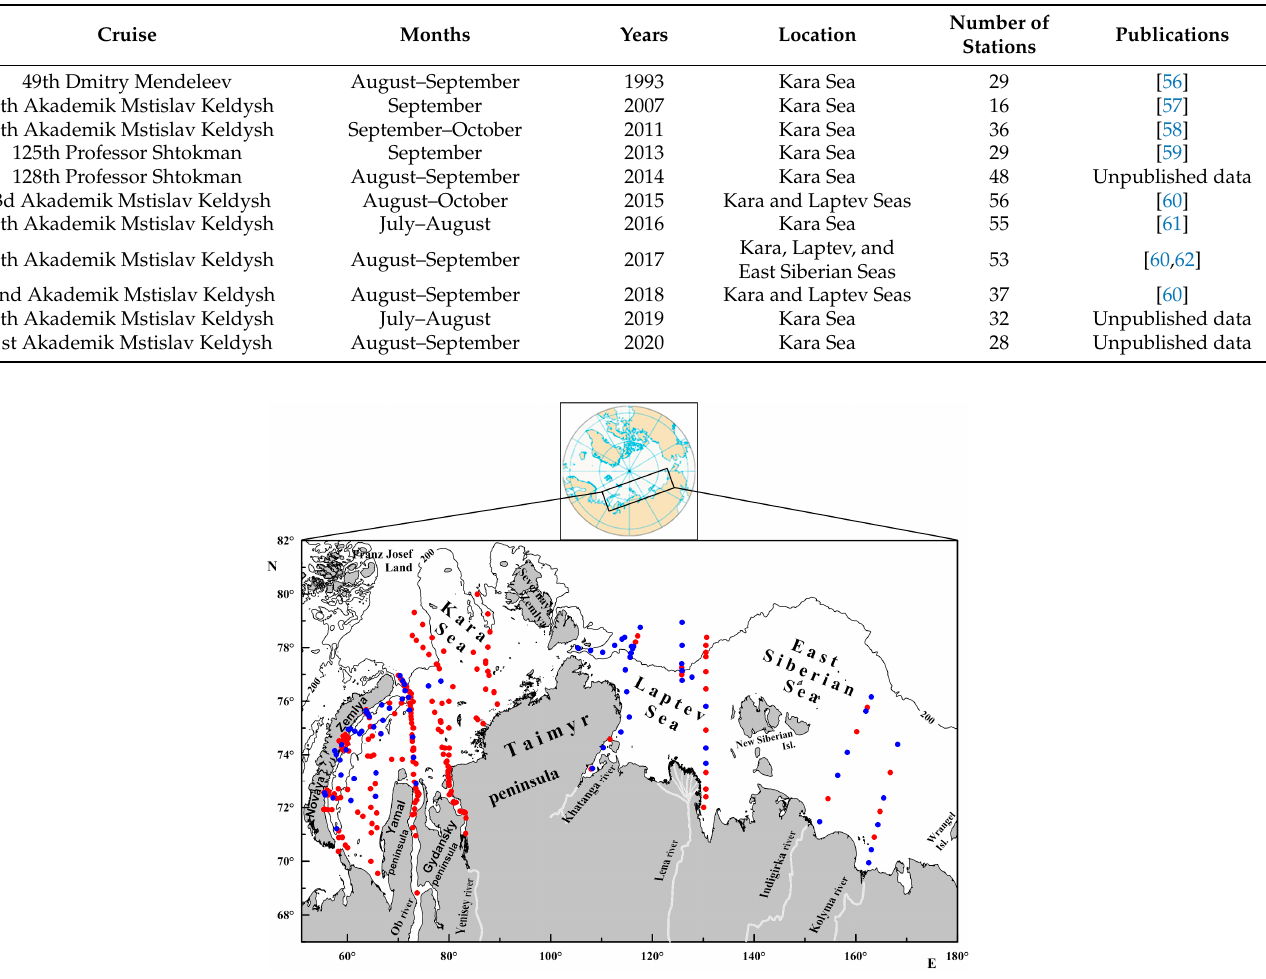
Figure 1. Locations of the sampling sites in the Siberian Seas where the calculations of the optimal assimilation number (P bopt ) were performed. The red circles indicate the sites where the calculations of P bopt of the total phytoplankton were carried out. The blue circles indicate the sites where the calculations of P bopt of size-fractionated phytoplankton were performed. The sampling depths were defined after a preliminary sounding of temperature, con- ductivity, and chlorophyll fluorescence using a CTD probe SBE-19 and SBE-32 (Seabird Electronics Inc., Bellevue, USA). Niskin bottles were deployed at the stations to obtain water samples from discrete depths within the upper 100 m layer. Trace metal cleaning procedures (e.g., Teflon-coated covers and springs for the Niskin bottles) [63] were used during all the cruises. 2.2. The Field Data The methods for determining PP and Chl a are described in detail in previous studies [47,57]. PP was estimated on board using a radiocarbon technique [64] according to sim- ulated in situ approach. Acid-cleaned 160 mL bottles with water samples after the addi- tion of sodium bicarbonate (NaH 14 CO 3 , 0.05 μ Ci per 1 mL of sample) were placed under neutral lighting filters and exposed for half of a light day in a deck incubator with the seawater temperature maintained at the in situ conditions. The transparency of neutral lighting filters was chosen based on the light exposure conditions at the sampling depths after the sounding of underwater photosynthetically available radiation (PAR). After ex- posure, the samples were filtered onto a 0.45 μ m nitrocellulose membrane “Vladipore” (Vladipore, Vladimir, Russia). After filtration, the samples were treated with 0.1 N HCl and filtered seawater, dried overnight, and placed in a scintillation vial with 10 mL of the